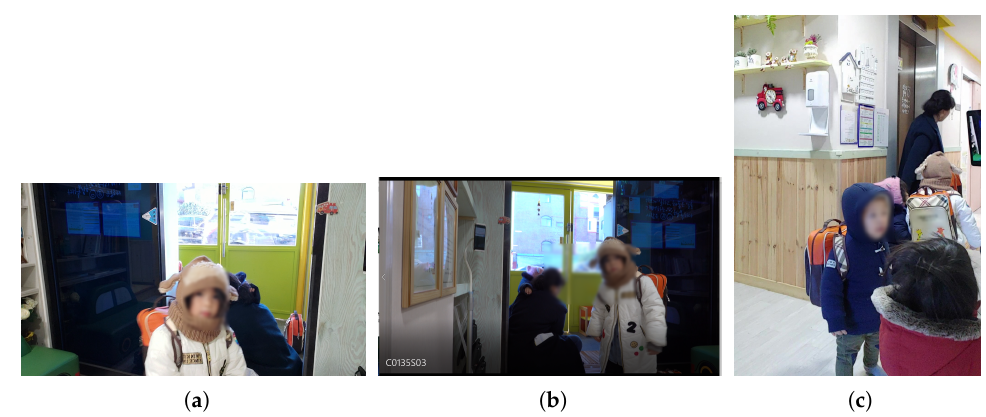
Figure 17. Actual captured images in Figure 16: ( a ) smartphone 1; ( b ) smartphone 2; ( c ) tablet PC.